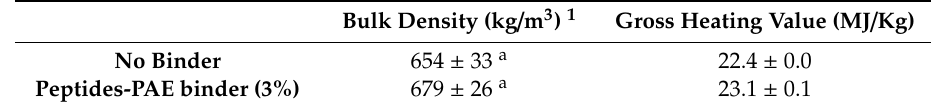
Table 3. Comparison of bulk density and gross heating value of torrefied wood pellets (dry basis) made with or without